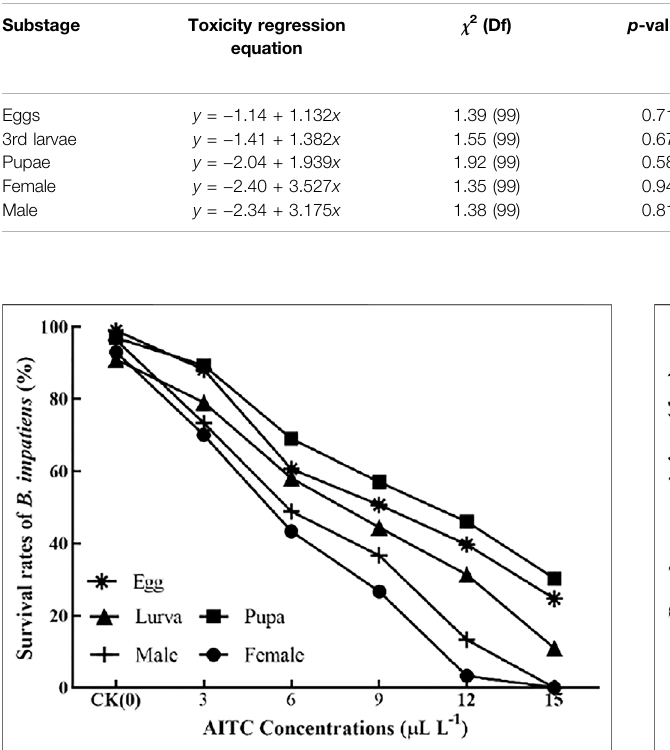
FIGURE 2 | Changes in the third larval stage, fourth larval stage, and pupal stage of B. impatiens after sub-lethal concentration fumigation of AITC. Data represent mean ± SD of three replicates. Different lower-case letters indicate statistically signi fi cant difference between sub-lethal concentrations by Tukey ’ s test ( p <